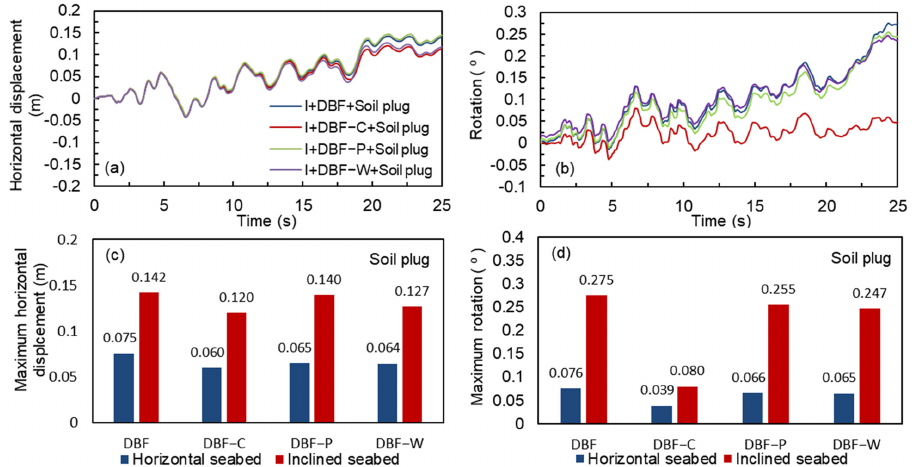
Figure 15. Response of the deep bucket foundation (DBF) with different reinforcement types in 50% relative density inclined liquefiable seabeds: ( a ) horizontal displacement time histories of deep bucket foundation (DBF) with different reinforcement types ; ( b ) rotation time histories of deep bucket foundation (DBF) with different reinforcement types; ( c ) The maximum horizontal displace- ment of deep bucket foundation (DBF) with different reinforcement types; ( d ) The maximum rota- tion of deep bucket foundation (DBF) with different reinforcement types. Figure 16 shows the horizontal displacement and rotation of the wide bucket foun- dation with different reinforcement types. The displacement and rotation of the bucket with inner compartment reinforcement was smallest, which means that the WBF-C is the most effective reinforcement type to improve the seismic performance of wide bucket foundation. However, for the wide bucket foundation, the application of an outer wing and pile can also significantly reduce the rotation of the bucket. The effect of reinforce- ment types on maximum bucket displacement and rotation for wide bucket foundations in both horizontal and inclined seabeds are shown in Figure 16c,d. In horizontal seabed, compared with the case without reinforcement, bucket displacement was reduced by 30.3%, 21.1% and 17.1% for DBF-C, DBF-P and DBF-W, respectively; and bucket rotation was reduced by 52.6%, 39.7% and 37.9% for DBF-C, DBF-P and DBF-W, respectively. In inclined seabed, compared with the case without reinforcement, bucket displacement was reduced by 21.9%, 7.5% and 3.4% for DBF-C, DBF-P and DBF-W, respectively; and bucket rotation was reduced by 71.1%, 70.1% and 43.7% for DBF-C, DBF-P and DBF-W, respec- tively.